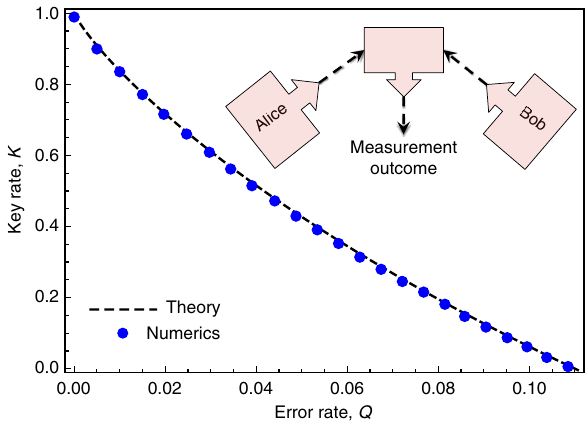
Figure 2 | Key rate for MDI QKD with the BB84 signal states. The inset shows the basic idea of MDI QKD: Alice and Bob each prepare a signal state and send it to an untrusted node, which performs an (untrusted) Bell-basis measurement and announces the outcome. Our numerics (circular dots) essentially reproduce the known theoretical dependence of the key rate on the error rate (dashed curve), which is the same expression as that given in (20). See Supplementary Note 1 for